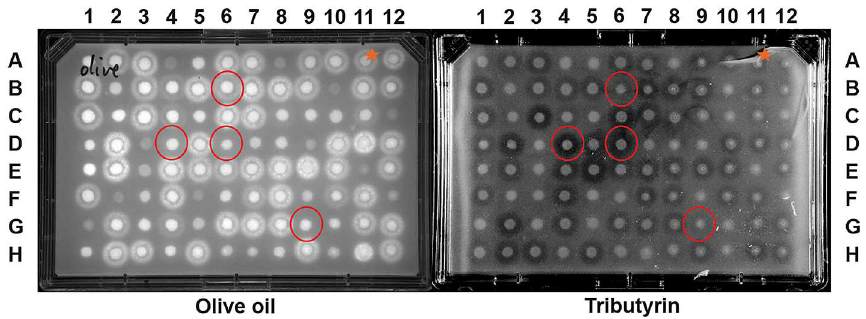
Fig 4. An example set of plates of the randomly-mutated library 10 screenedagainst olive oil/ rhodamine (left), and tributyrin (right). Red circles indicate variants able to discriminate between the hydrolysisof short and long chain fatty acids. The fatty acid substrate is emulsifiedat 2.5% w/v into auto- inductionagar medium and rhodamineis at 0.001% w/v. An orangestar indicateswild-type